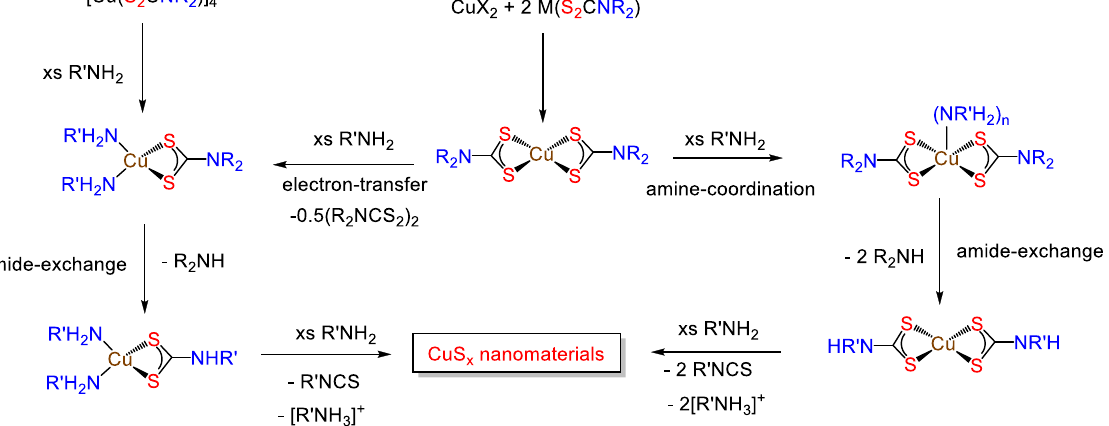
Figure 24. Proposed mechanism for the formation of copper sulfides upon heating copper dithiocarbamate SSPs in primary amines.